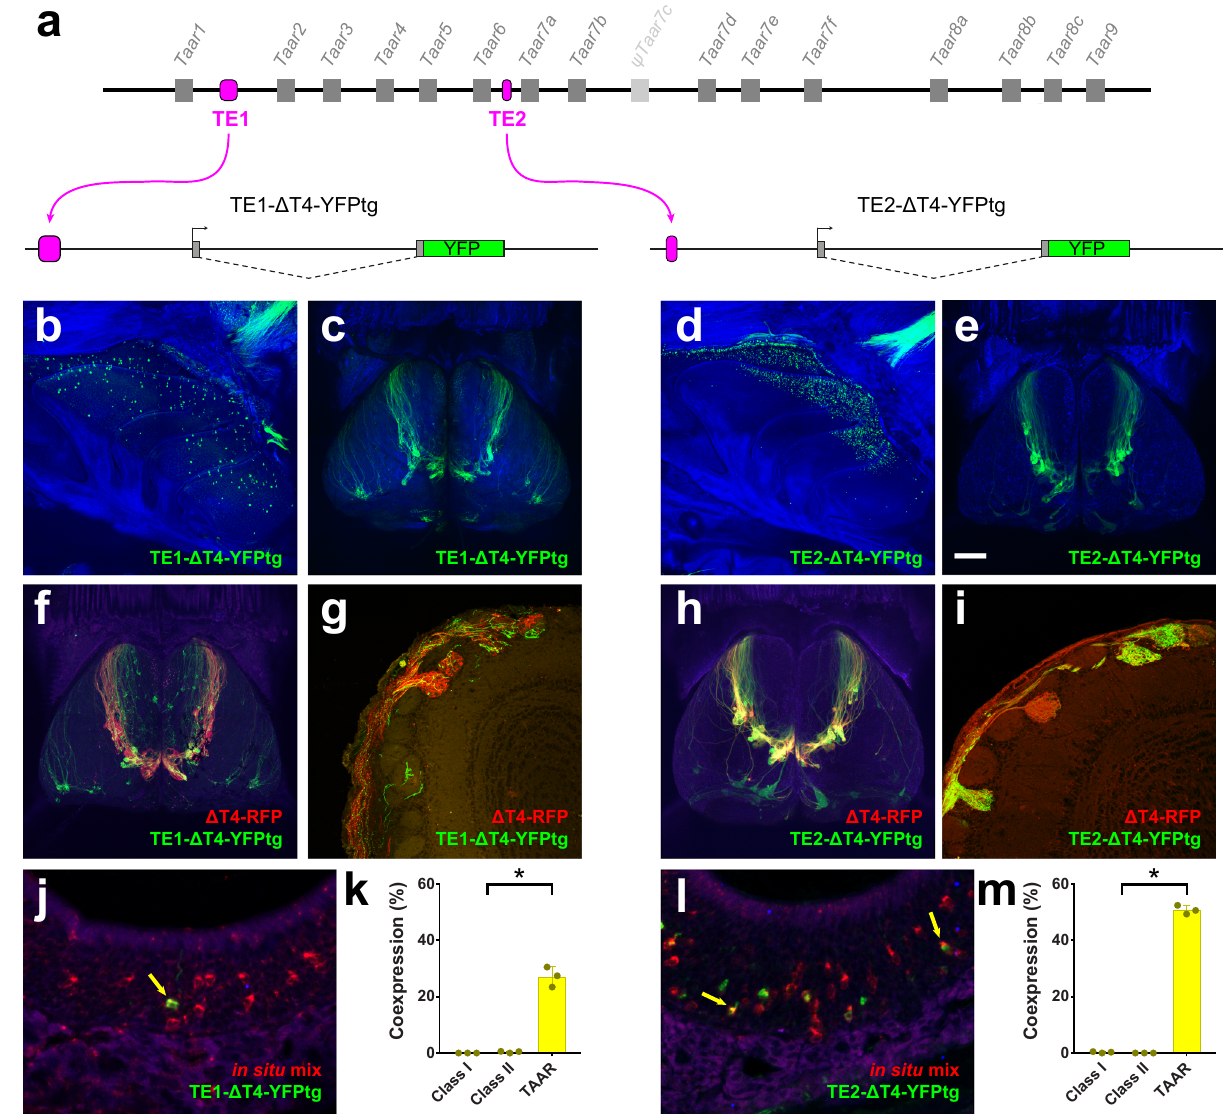
Fig. 5 TE1 and TE2 drive expression of the TAAR4 transgene. a Top, schematic of TAAR cluster showing placement of TE1 or TE2 (magenta). Bottom, diagram of Δ T4-YFP transgenes in which TE1 and TE2 are inserted upstream of the Taar4 promoter and YFP coding sequence (green). b – e Wholemount confocal images of olfactory epithelium and olfactory bulb of TE1- Δ T4-YFPtg and TE2- Δ T4-YFPtg mice showing YFP expression in OSNs in the epithelium and labeled axons and glomeruli in the dorsal olfactory bulb. OSN axons project to a cluster of dorsal glomeruli, reminiscent of the endogenous TAAR glomeruli. f Confocal image of dorsal olfactory bulbs, and g histological section, of a mouse that has the TE1- Δ T4-YFPtg and a Δ T4-RFP targeted allele. RFP + and YFP + axons target the same glomeruli. h Confocal image of dorsal olfactory bulbs, and i histological section, of a mouse that has the TE2- Δ T4- YFPtg and a Δ T4-RFP targeted allele. RFP + and YFP + axons target the same glomeruli. j , l Combined in situ hybridization (TAAR probe mix, red) and immunohistochemistry for YFP (green) in histological sections of olfactory epithelium from TE1- Δ T4-YFPtg ( j ) and TE2- Δ T4-YFPtg ( l ) mice. Co- expressing cells indicated by yellow arrows. k , m Fraction of YFP + cells that label with the class I, class II, or TAAR probe pools in TE1- Δ T4-YFPtg ( k ) and TE2- Δ T4-YFPtg ( m ) animals ( n = 3 mice). Error bars indicate mean ± SEM. * p < 0.0001; two-sided, one-way ANOVA, Dunn – Š idák correction for multiple comparisons. Scale bar in e = 500 µ m in b , c , d , e, f, and h ; 100 µ m in g and i ; 25 µ m in j and l